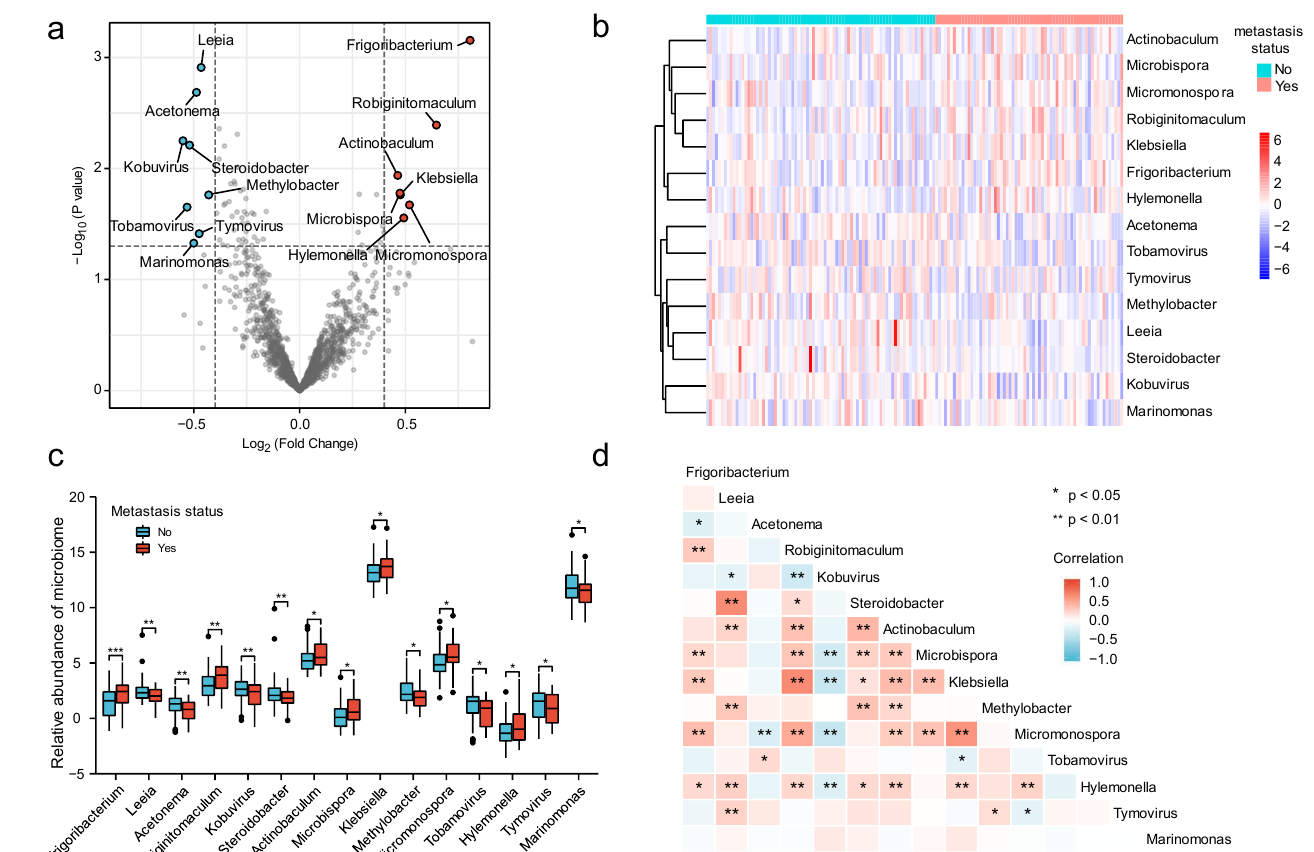
Figure 2. Identification and comparison of microbiomes associated with cervical cancer metastasis. ( a ) Volcano plot of differentially expressed microbiomes, with red dots indicating high expression in the metastasis group, and blue dots indicating high expression in the non-metastasis group; ( b ) heatmap showing the relative abundance of 15 microbiomes in each sample; ( c ) box plots comparing the relative abundance of 15 microbiomes between the metastasis and non-metastasis groups; and ( d ) analysis of Spearman’s correlation between 15 microbiomes. ( p < 0.05 *; p < 0.01 **; p < 0.001 ***)